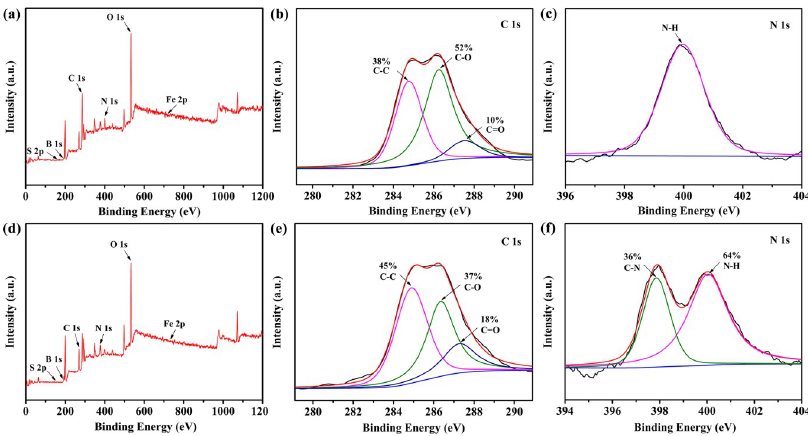
Fig 3. XPS full-scan spectrum of (a) simulated fracturing fluid-0 and (d) simulated fracturing fluid (after gel- breaking). High-solution C 1s XPS spectra of (b) simulated fracturing fluid-0 and (e) simulated fracturing fluid. High- solution N 1s XPS spectra of (c) simulated fracturing fluid-0 and (f) simulated fracturing fluid.